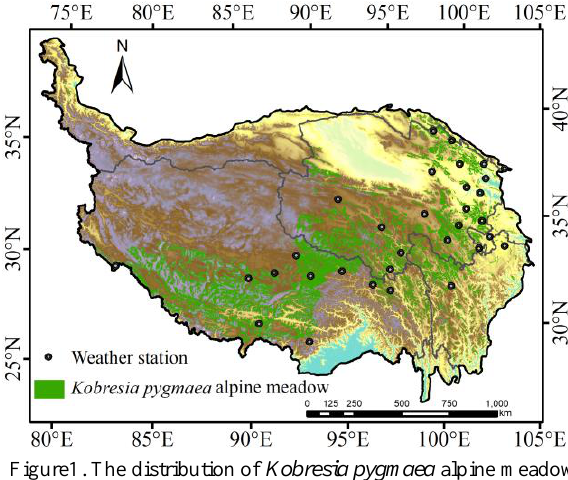
Figure1. The distribution of Kobresia pygmaea alpine